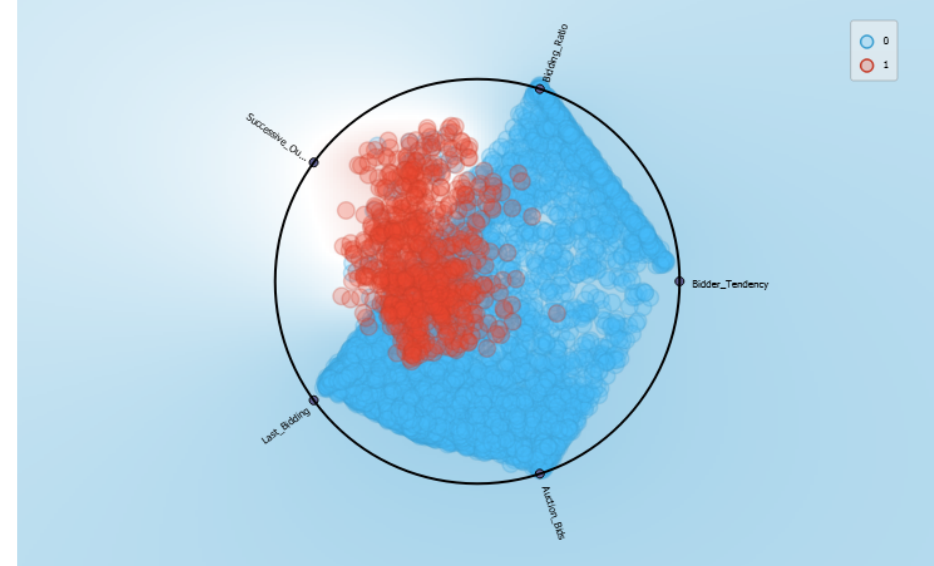
Figure 7. Radviz projection—Auction Fraud data